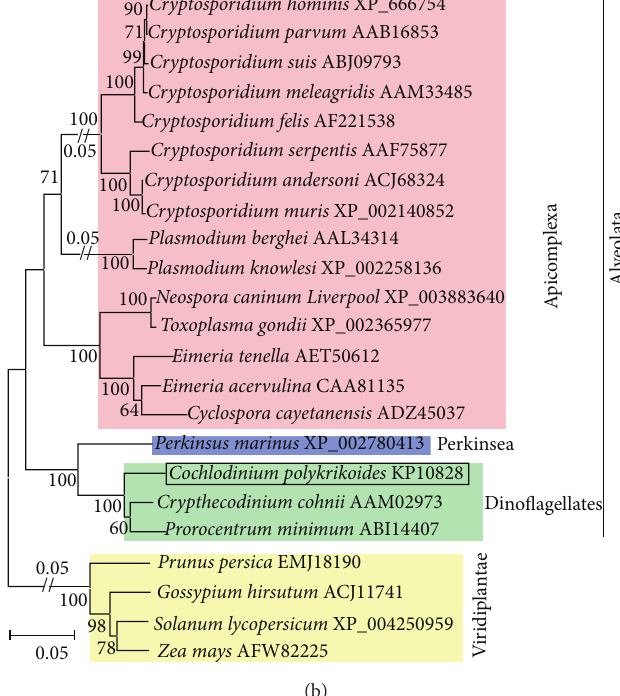
Figure 2: The cDNA and its predicted amino acid sequences of CpHSP70 and neighbor-joining tree of dinoflagellate HSP70s. (a) The cDNA and its predicted amino acid sequences: the conserved amino acids domains were marked in grey; the end domain “EEVD” was boxed; (b) the phylogenetic tree was constructed in the MEGA 5 (bootstrap method with 1,000 replicates), and the scale bar represents the number of amino acid substitutions per site. CpHSP70 was determined in the present study and marked in a box. Other dinoflagellates HSP70s and outgroup were obtained from NCBI database.